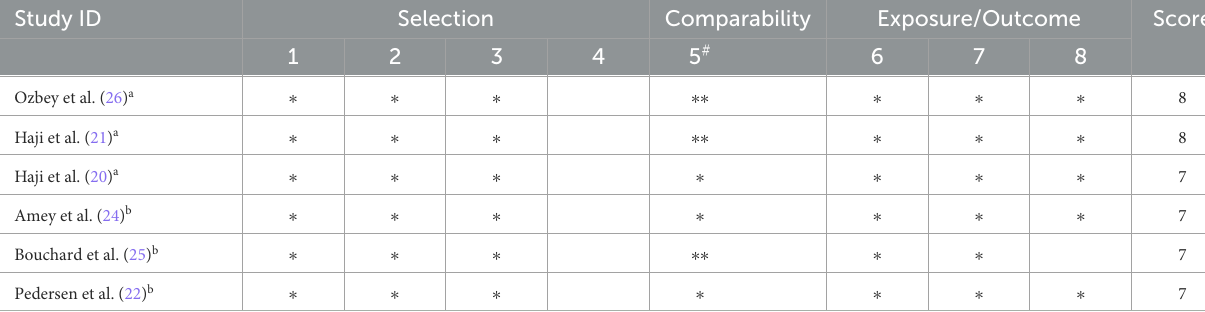
TABLE 2 Quality assessment of the cohort and case–control studies. Study ID